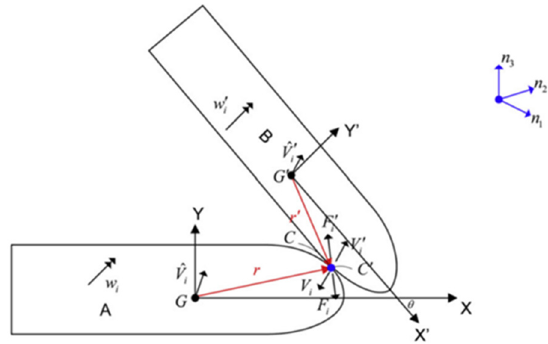
Figure 14. The coordinate system for the collision.